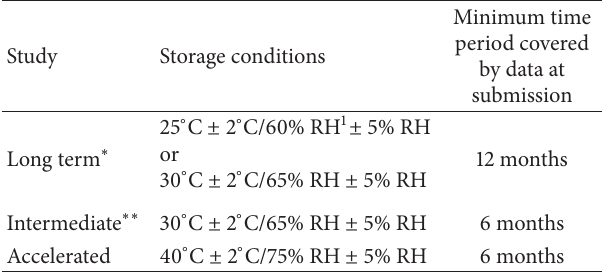
Table 1: General conditions for stability examination